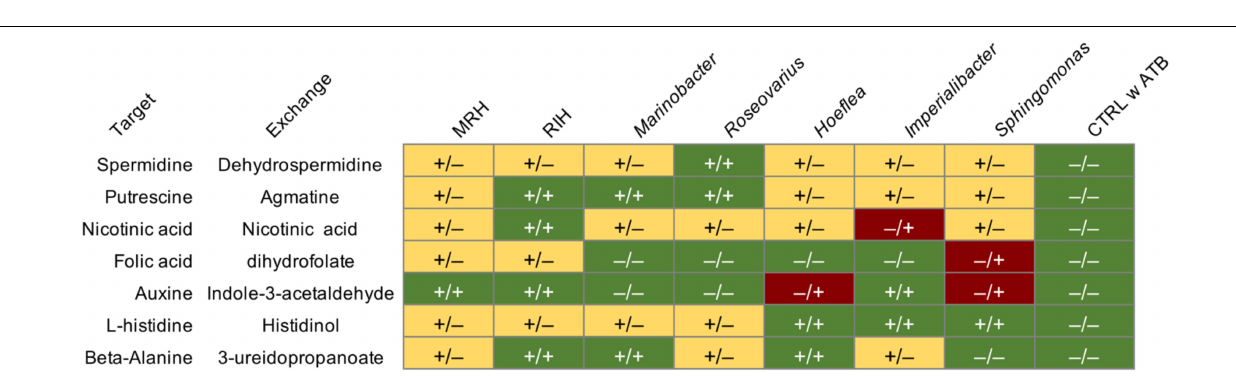
FIGURE 3 | Comparison of predicted production of target metabolites in co-cultures based on metabolic networks (symbol before the slash) and results from targeted UPC 2 -MS analyses of algal filaments after 28 days (symbol after the slash). The column “Exchange” indicates one possible compound provided by the microbiome leading to the production of the compound in the column “Target” in the algal metabolome; it was these target metabolites that were tested for using UPC 2 -MS. All experiments were carried out in triplicate, each replicate of the same condition yielding identical results. (–): a target metabolite was not predicted/detected (+): a metabolite was predicted/detected. Green highlights conditions where predictions correspond to the in vivo observations, red highlights compounds that were detected although no pathway was predicted. Yellow indicates compounds potentially producible via bacterial exchanges that were not detected. MRH, Marinobacter – Roseovarius – Hoeflea ; RIH, Roseovarius – Imperialibacter – Hoeflea ; CTRL, control; ATB, antibiotic